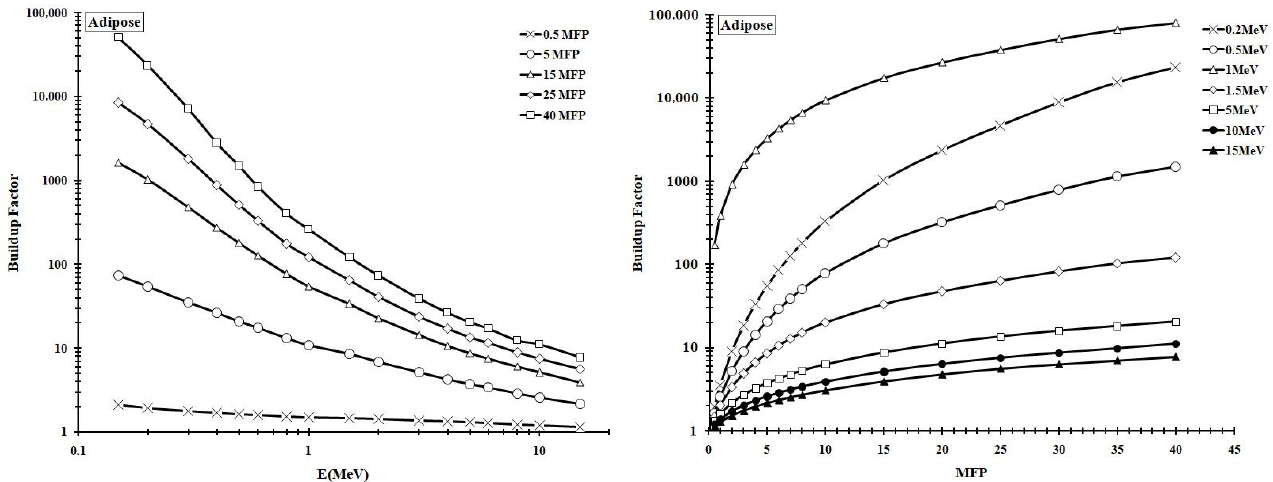
Figure 4. Buildup factor for adipose tissue as a function of: ( left side ) photon energy for fixed depths between 0.5 and 40 mfp and ( right side ) depth for a fixed photon energy between 0.15 and 15